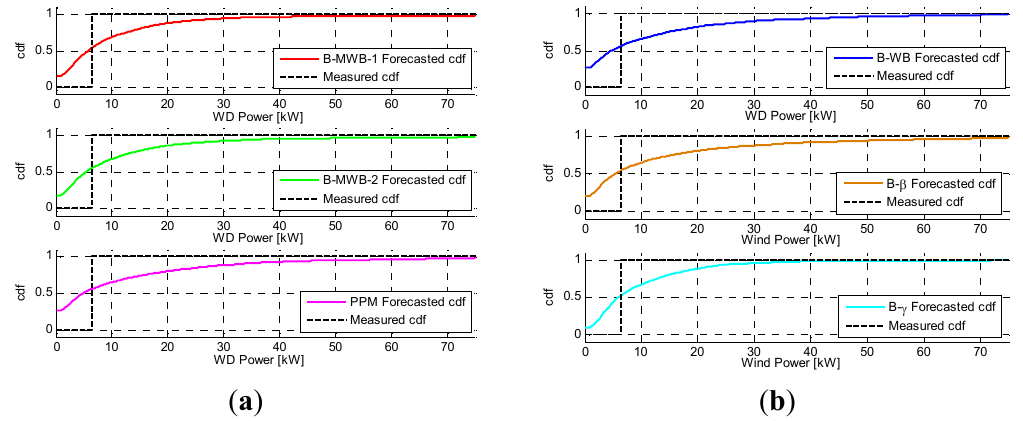
Figure 3. Forecasted CDFs compared to the CDFs of the actual value of wind power (at 1:00 PM on 04/07/2013); ( a ) Proposed methods: B-MWB-1 and B-MWB-2 cases, and PPM; ( b ) Bayesian methods with unimodal distributions: B-WB, B- β and B- γ